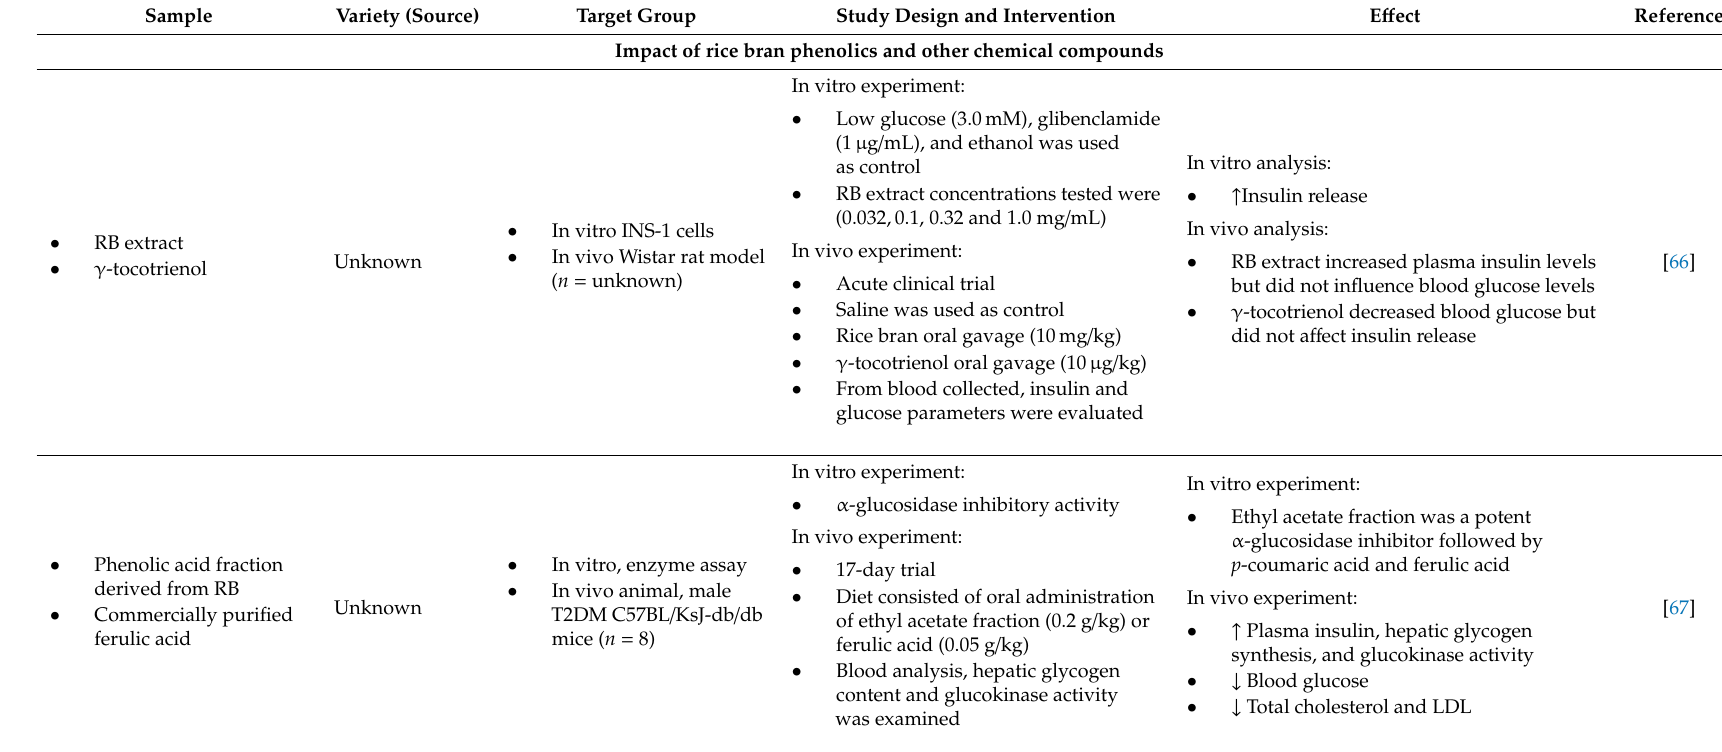
Table 2. In vitro and in vivo anti-diabetic role of rice bran-derived bioactive